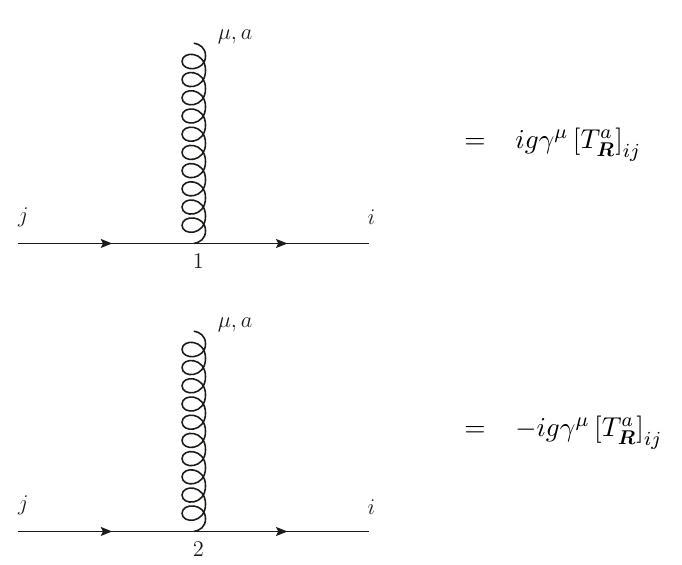
Figure 12. Feynman rules associated to the gauge boson-fermion-fermion vertex, given here for the time-ordered and anti-time ordered branches of the Schwinger-Keldysh contour, with the fermions in a representation R . The anti-time ordered branch multiplies the vertex factors by ( − 1) , which is naturally included in the notation we adopt in the main text.